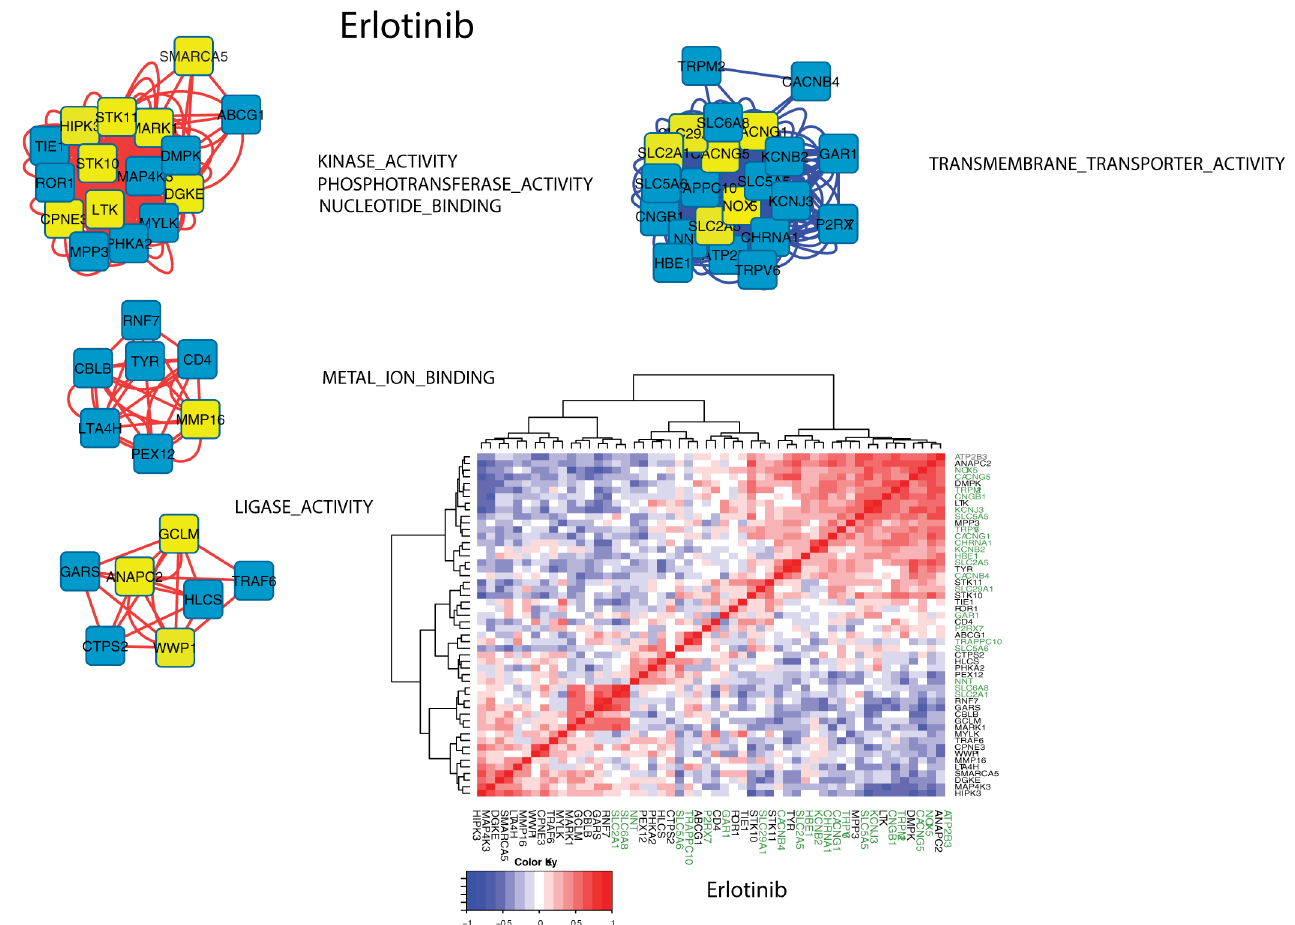
Fig 10. Cytoscapenetwork diagrams using pathway fitness scores as edge weights between pairwise pathway genes (nodes). Results displaynetworks for the upper and lower 20 th percentilesof fitness scores. For displaypurposes, meta-pathway labelsare used as abbreviations from those shown in Fig 4 . Four meta-pathways, comprisingfifty-two genes, are identified.Node edgesare colored to indicate relativegene expressions betweenresponder and non-responder groups (red: relative over expression, blue: relative under expression). Nodes for genes derived from pathway fitness scores are shown in yellow. The full pathway names for the meta-pathway labelsare: KINASE_ACTIVITY/PHOSPHOTRANSFERASE_ACTIVITY/NUCLEOTIDE_BINDING: